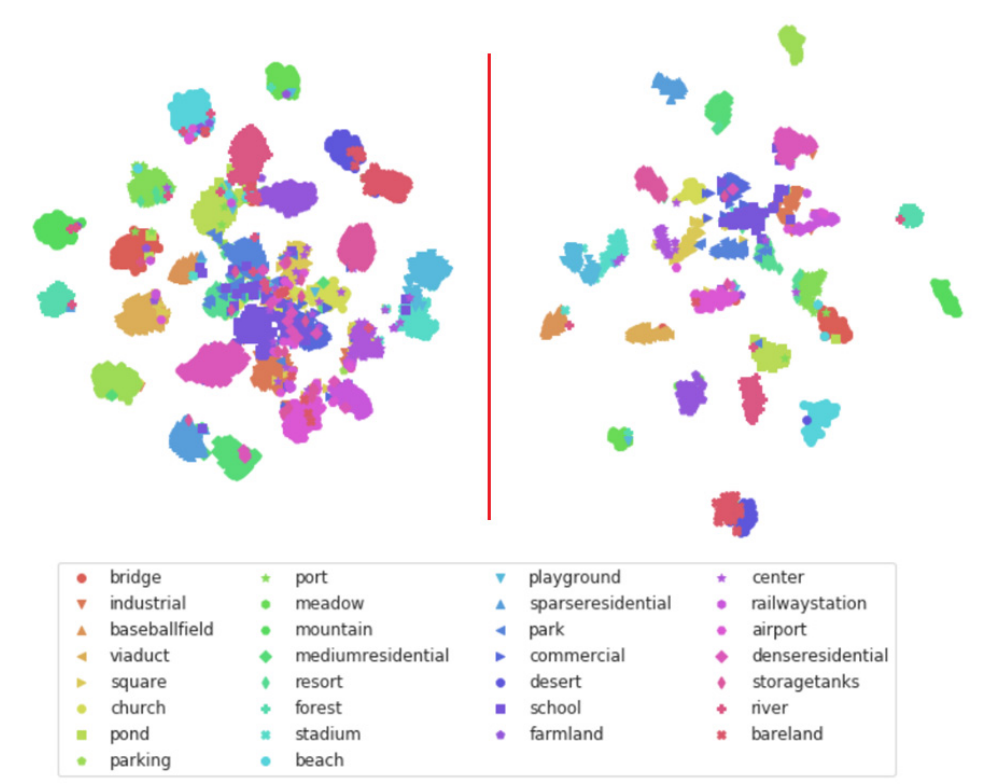
Figure 13. 2-D scatterplots of high-dimensional features generated with t-SNE over the AID dataset. ( left ) without center-loss function. ( right ) with center-loss function.